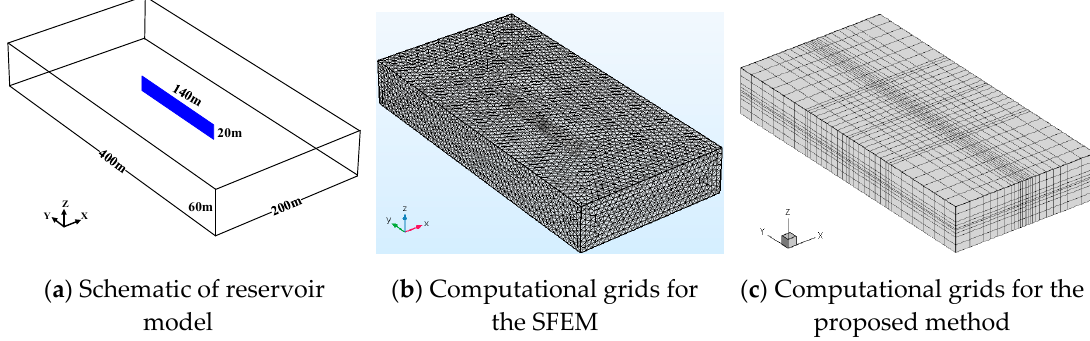
Figure 7. Schematic of reservoir model and the computational grids for two different methods.